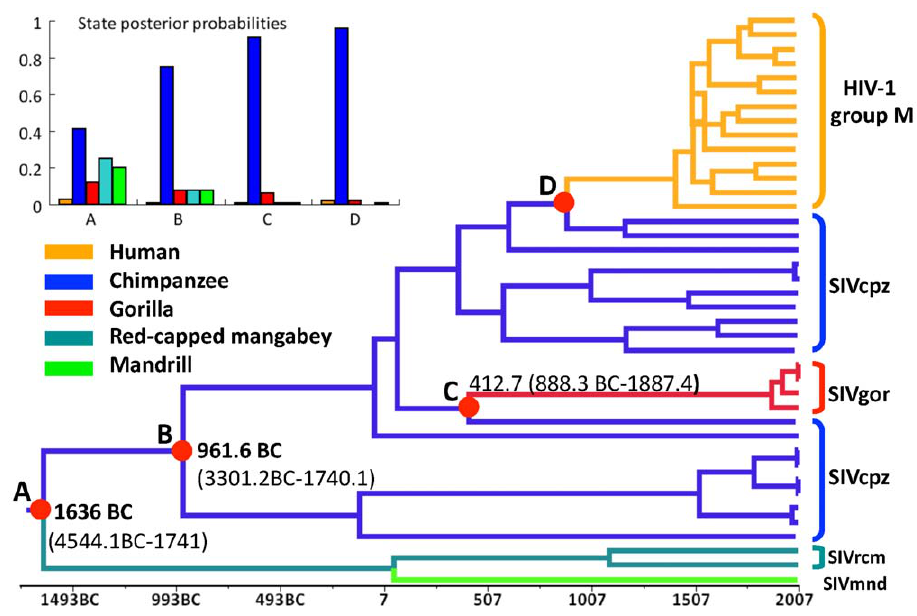
Figure 4. Maximum clade credibility tree of HIV-1 and different SIVs based on their RT genes. Ancestral host states were reconstructed using Bayesian phylogeographic inference framework implemented in the BEAST v1.6.2 package. The host state posterior probabilities of the most recent common ancestors (MRCAs) are shown on the left upper panel. The tree branches are colored according to their respective host species. The red solid nodes on the trees represent the MRCAs of corresponding virus strains. Estimated times of the MRCA are shown at corresponding nodes. BC: before Christ.